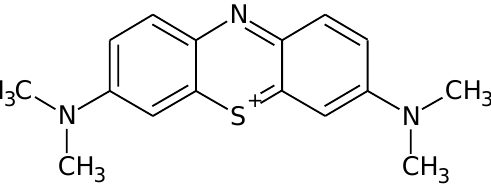
Figure 1. Chemical structure of cationic dye, Methylene Blue — C.I. 52015.